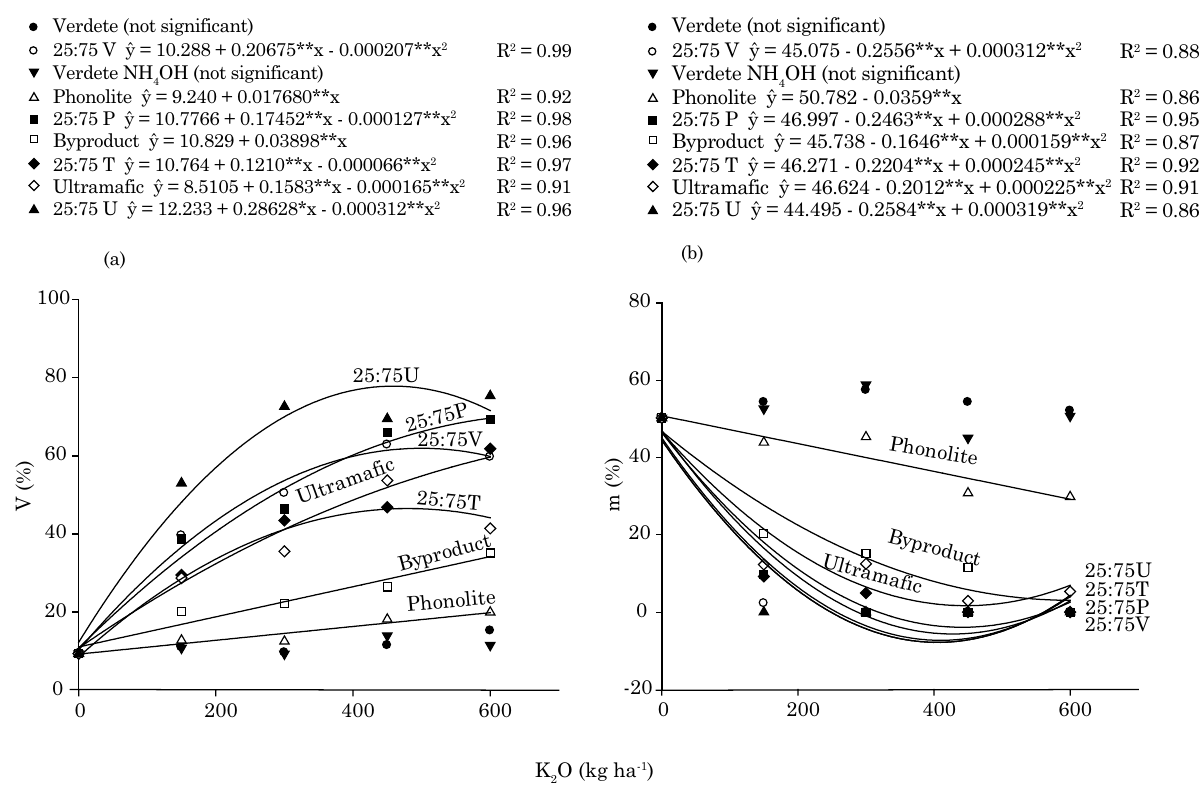
Figure 3. Values of: (a) base saturation (V) and (b) aluminum saturation (m) of soil as affected by the treatments, after 45-day